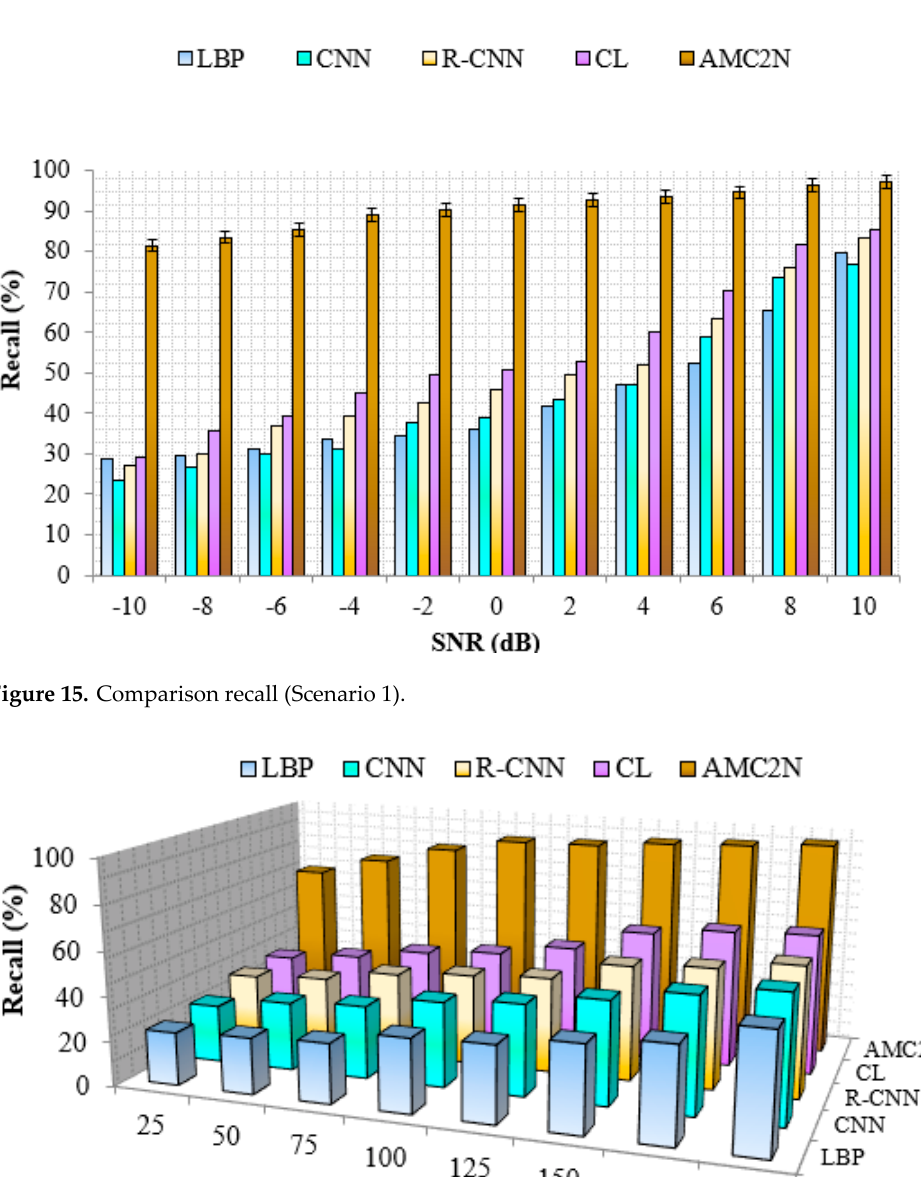
Figure 16. Comparison recall (Scenario 2).